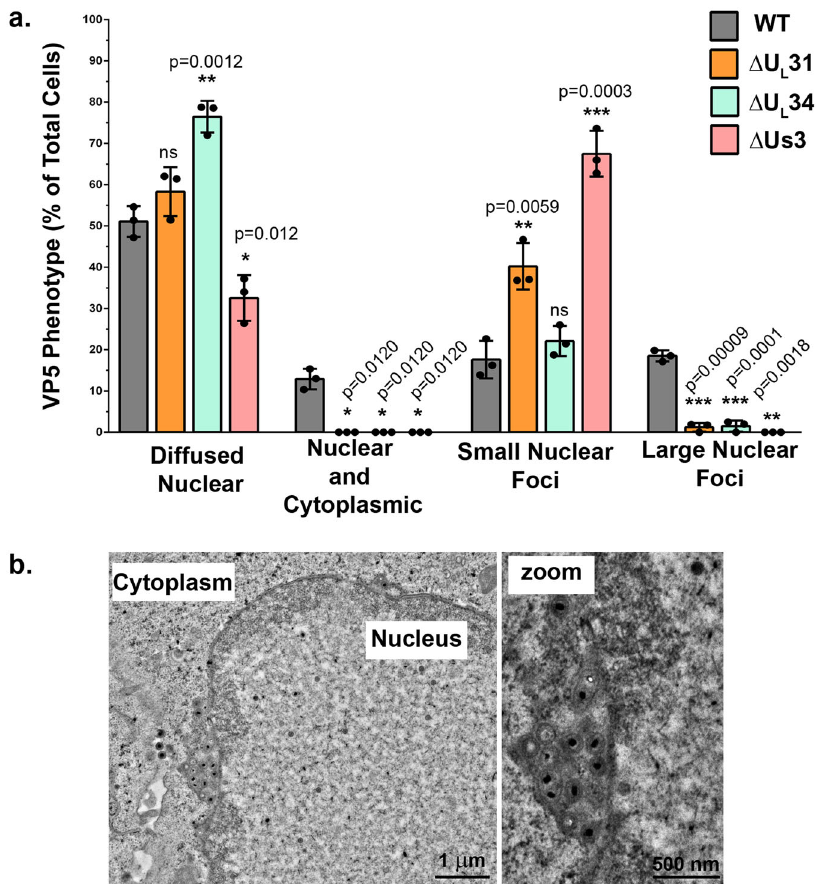
Fig. 8 Large elongated VP5 foci at the nuclear periphery are enveloped C-capsids. a HeLa cells grown on coverslips prior to infection. Twenty-four hours later, cells were infected with the Δ U S 3, Δ U L 31 or Δ U L 34 mutant viruses or corresponding wild-type virus (F strain) at an MOI of 5. At 9 hpi the cells were treated for conventional confocal microscopy and labelled for DDX3X, VP5 and pU L 34 (see Fig. S7 for IF images). At least 100 cells per condition were analyzed to quantify the intracellular VP5 distribution. The percentages are averages and standard deviations of the means of three individual experiments. Bilateral Student T -tests were performed and compared to wild-type virus (* p < 0.05, ** p < 0.01 and *** p < 0.001). b HeLa cells were infected with wild- type strain 17 + virus at an MOI of 5 for 9 h. Next, cells were fi xed and treated for electron microscopy. Several cells were imaged using by transmission electron microscopy. The images are representative of three independent